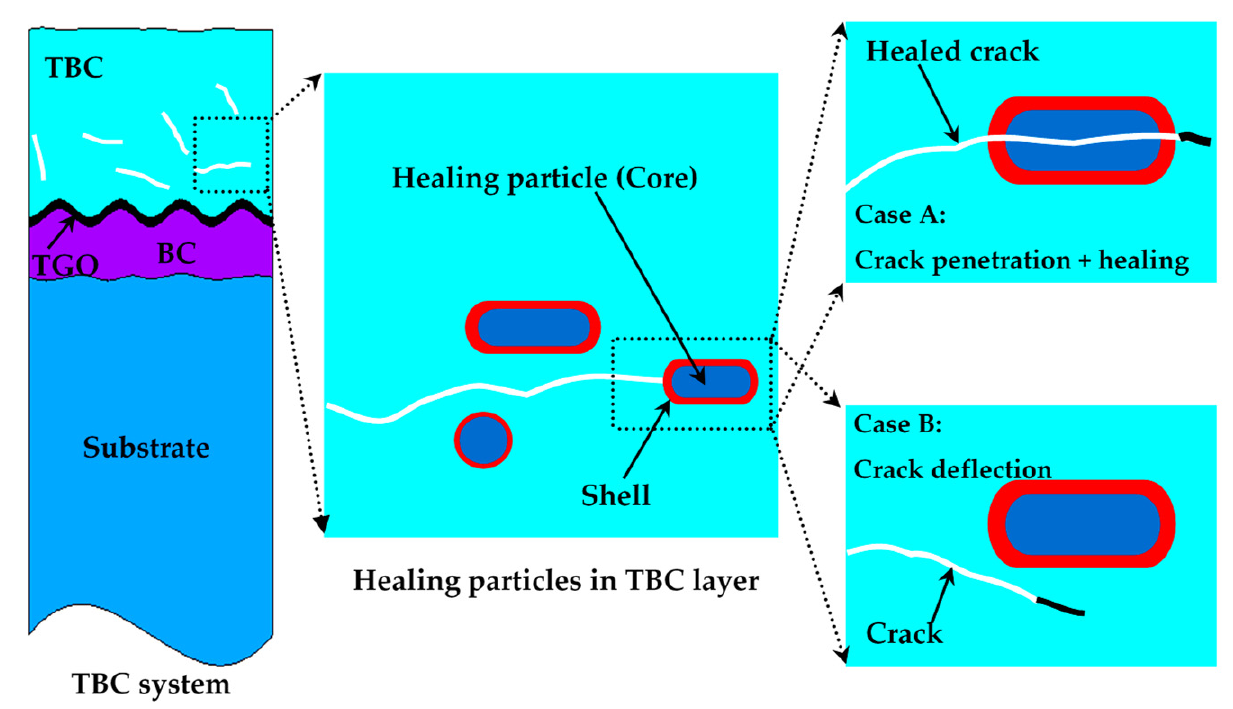
Figure 8. Schematic illustration of self-healing for the thermal barrier coatings [55].